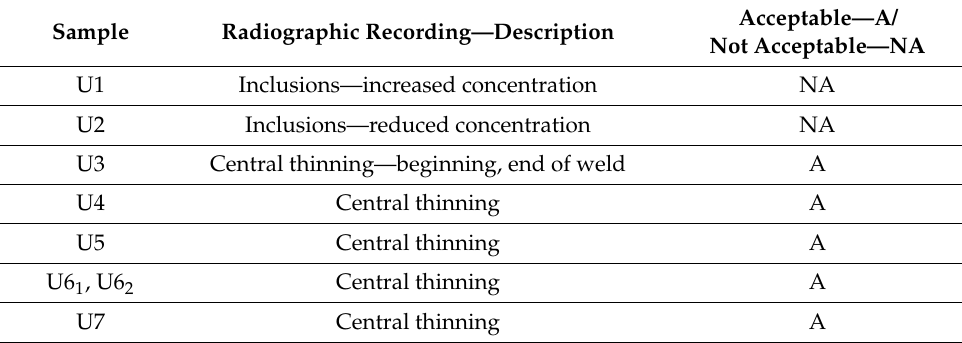
Figure 5. Radiographic control of the U1 sample. Table 5. Results of radiographic